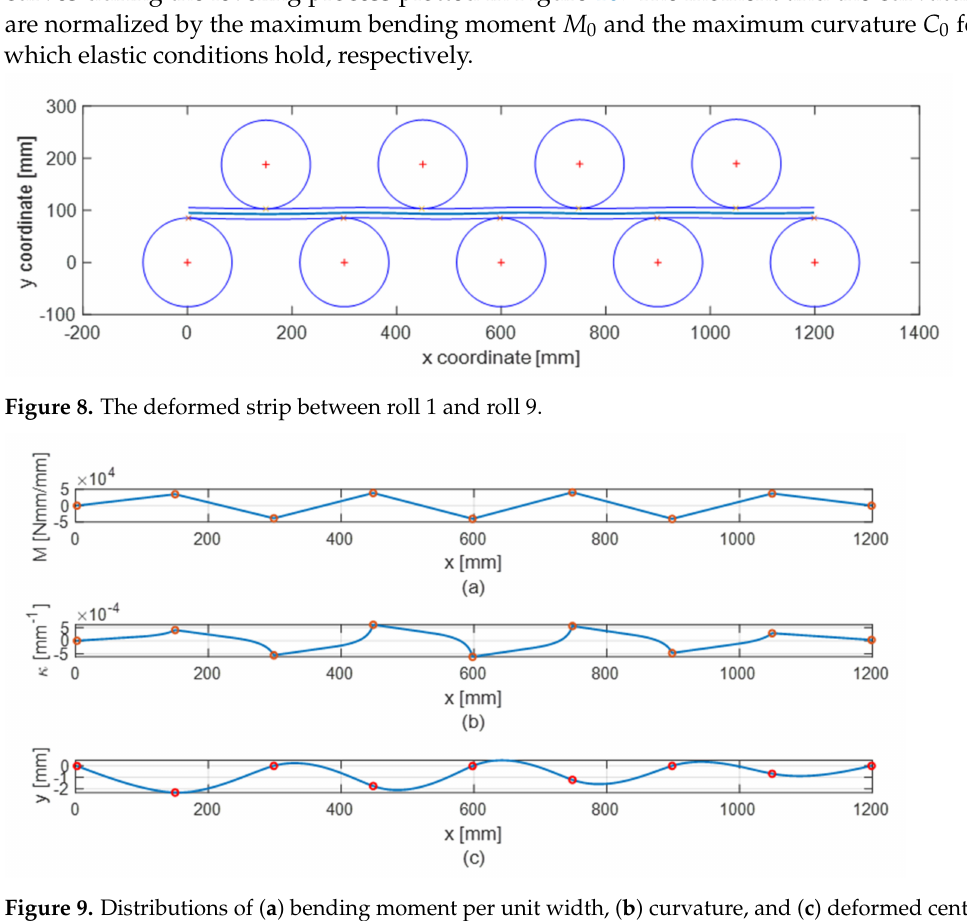
Figure 9. Distributions of ( a ) bending moment per unit width, ( b ) curvature, and ( c ) deformed center line of the strip between roll 1 and roll